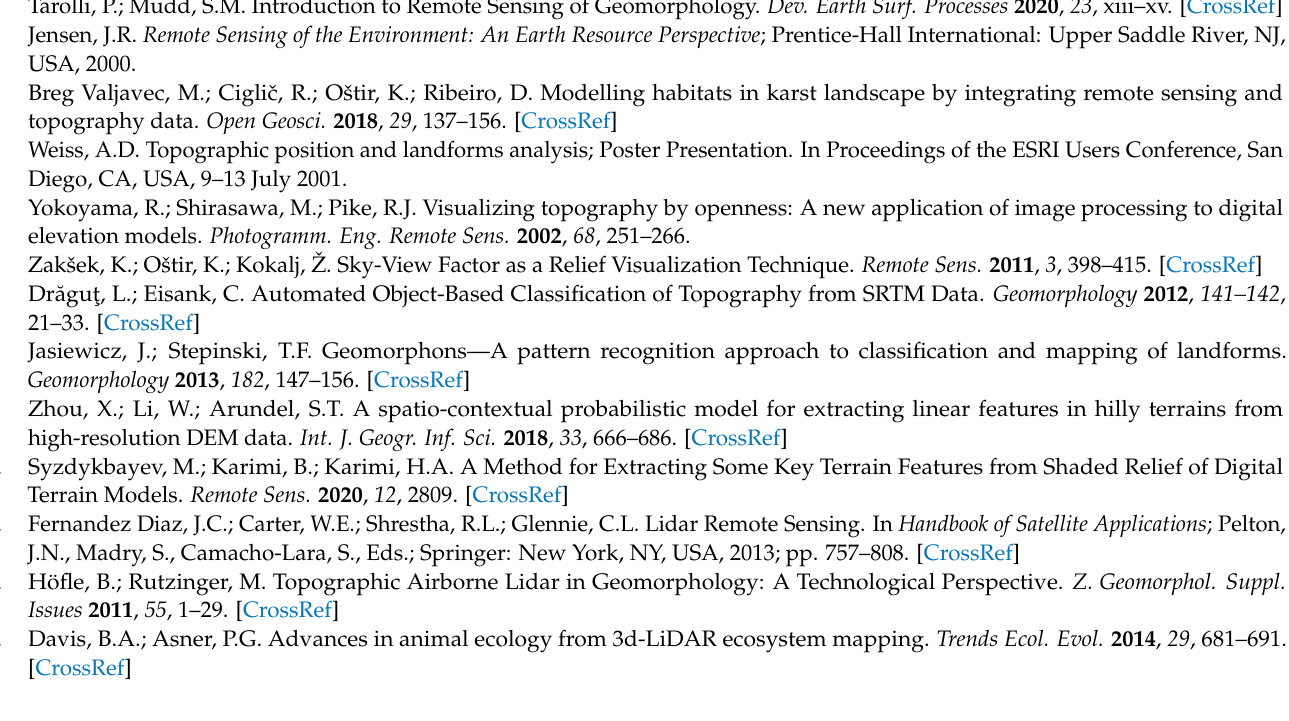
Figure S3: Map of geomorphological characteristics of karst depressions based on slope; Table S1: Range of values [Min-Max] and associated median [median ± IQR] for each covariate per species, for both used and available